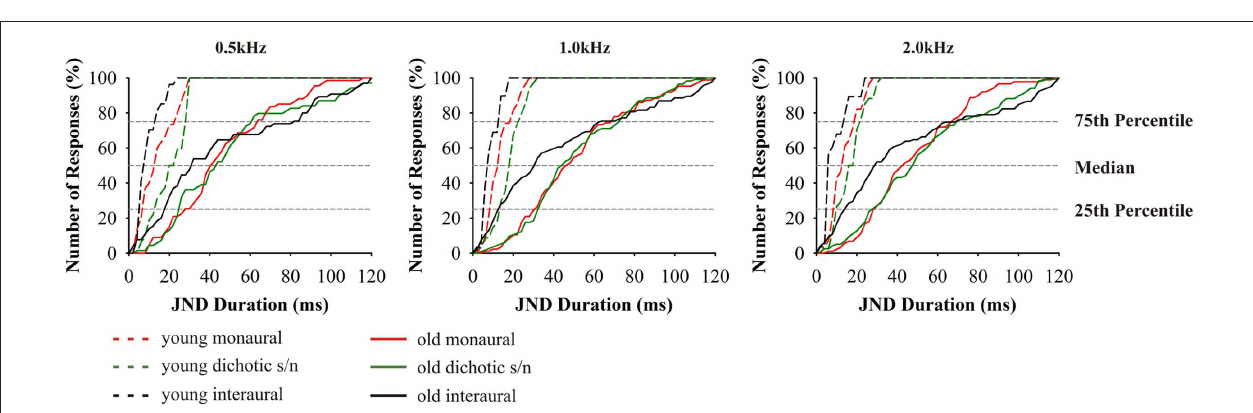
FIgure 6 | Cumulative distributions of JND of duration discrimination. From left to right results for the test frequencies 0.5, 1.0, and 2.0 kHz. Design of the graph like in Figure 4 . The different age groups are indicated by the different